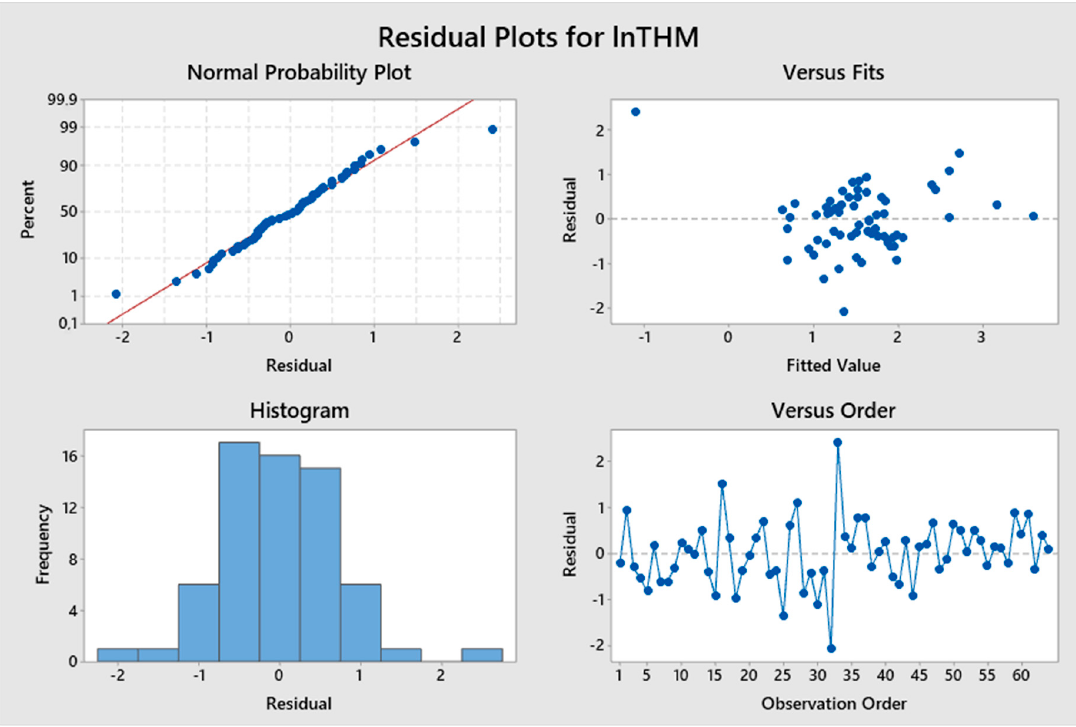
Figure 3. Residual plots for model (4). Water 2020 , 12 , x FOR PEER REVIEW